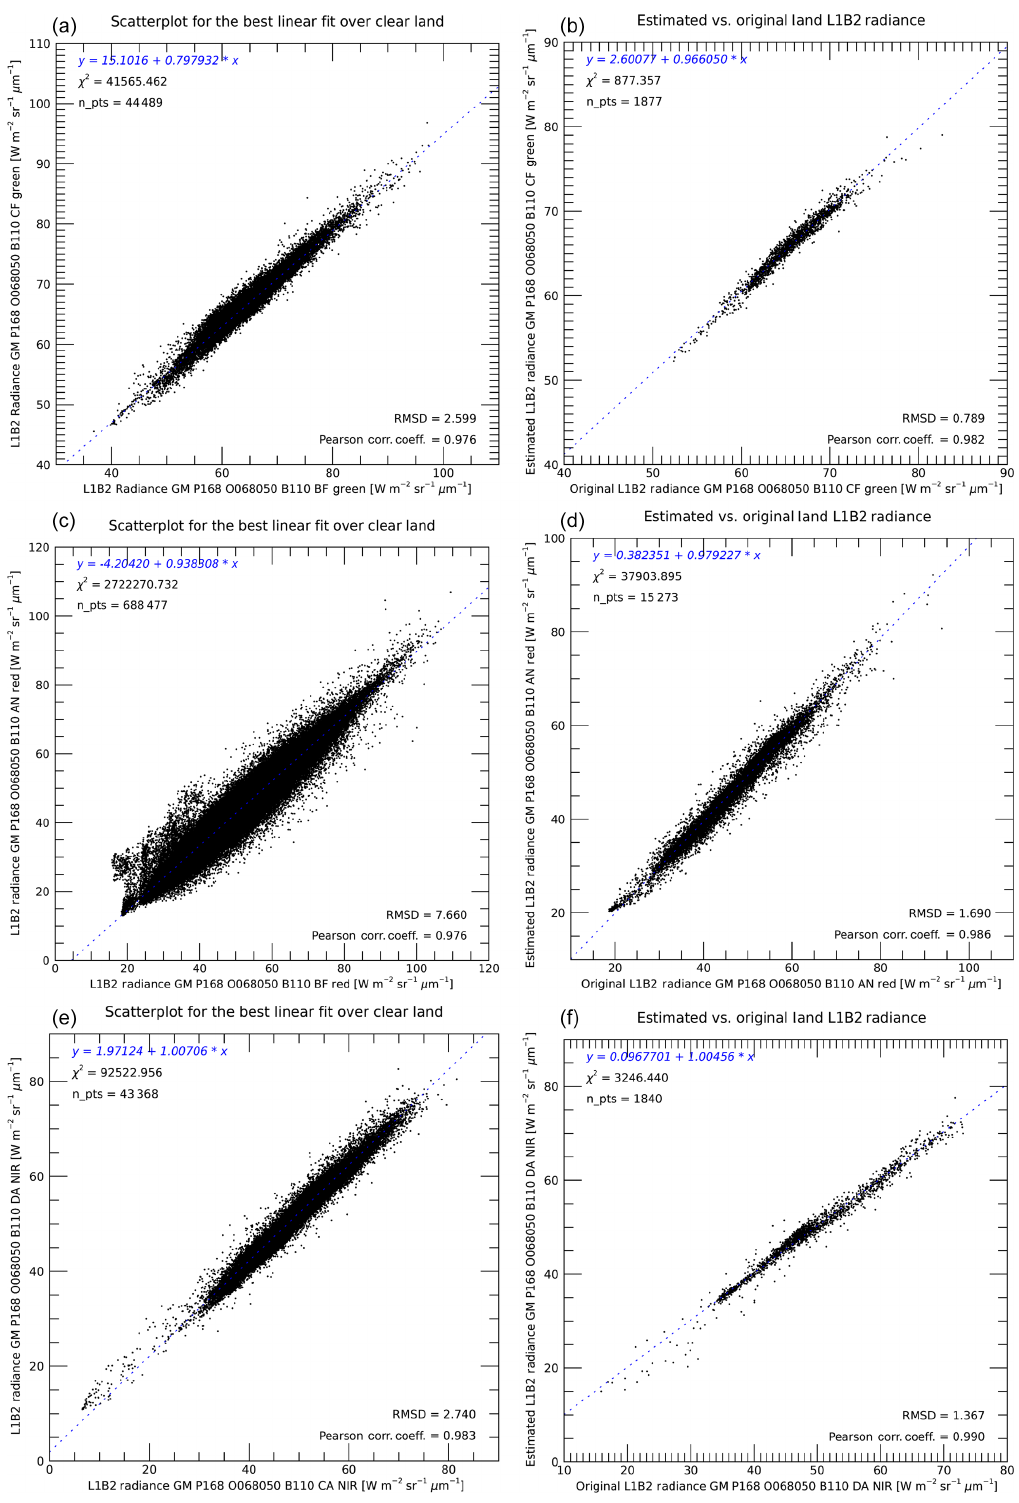
Figure 18. Scatterplots of the reconstructed versus the original values in the three data channels where missing values were artificially introduced as shown in Fig. 17: the top, middle and bottom panels concern the CF/green, AN/red and DA/NIR data channels, and in each case, the left panel shows the best predictor (abscissa) for the affected data channel (ordinate), while the right panel exhibits the relationship between the original (abscissa) and the reconstructed (ordinate) values in the areas where missing values were artificially introduced. Note that the ranges of values are different for each plot in order to optimize the view of the